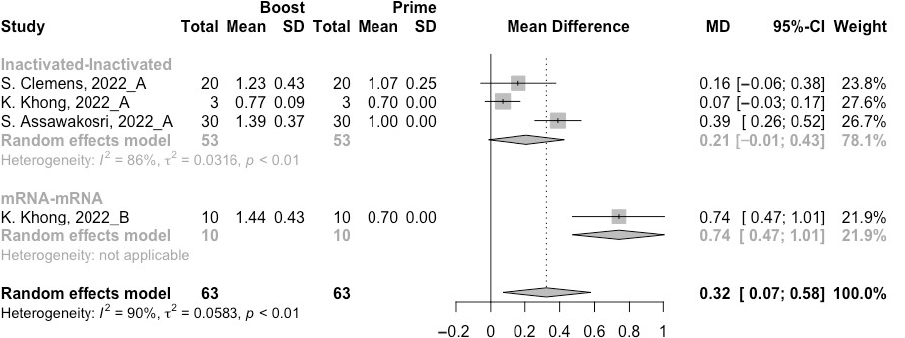
Figure 8. Forest plot of the pooled log-transformed neutralization titers against the Omicron variant before and after homologous booster vaccination.